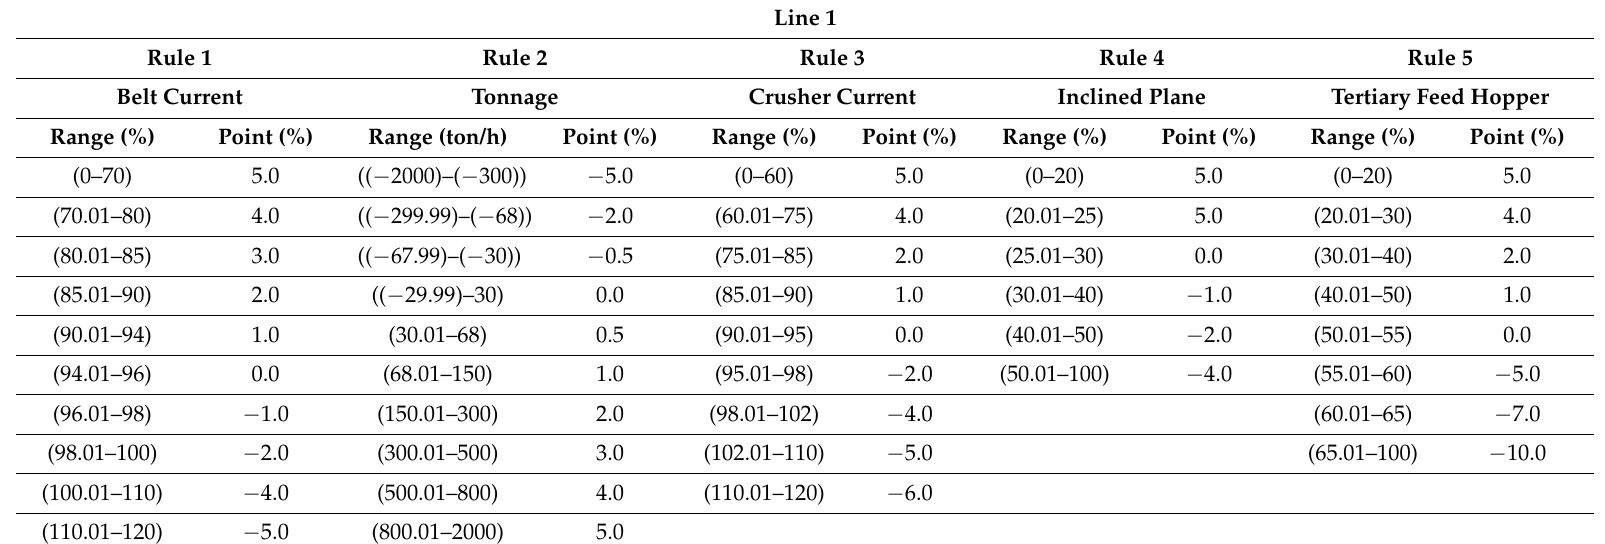
Table 2. Established Operational Ranges: Secondary Crusher Line 1, Expert System